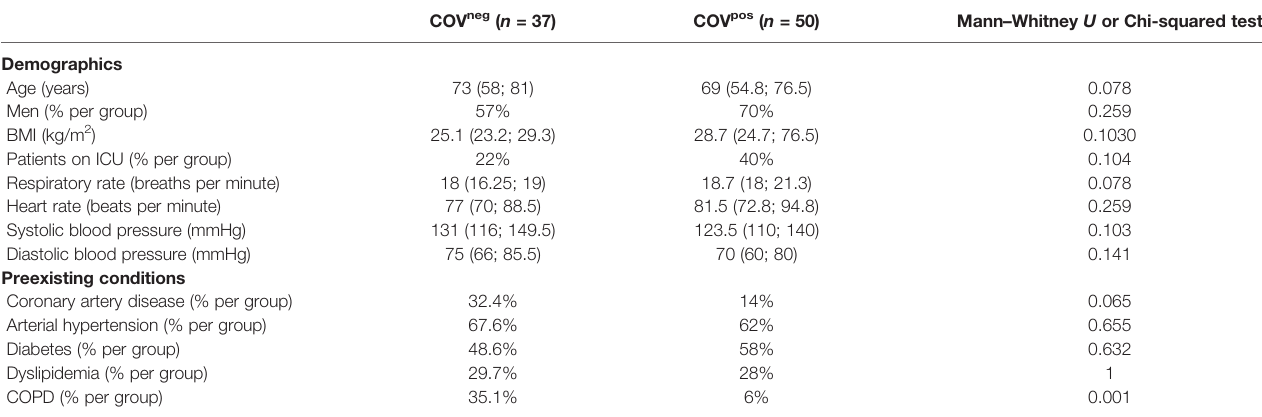
TABLE 1 | Patient characteristics — demographics and preexisting